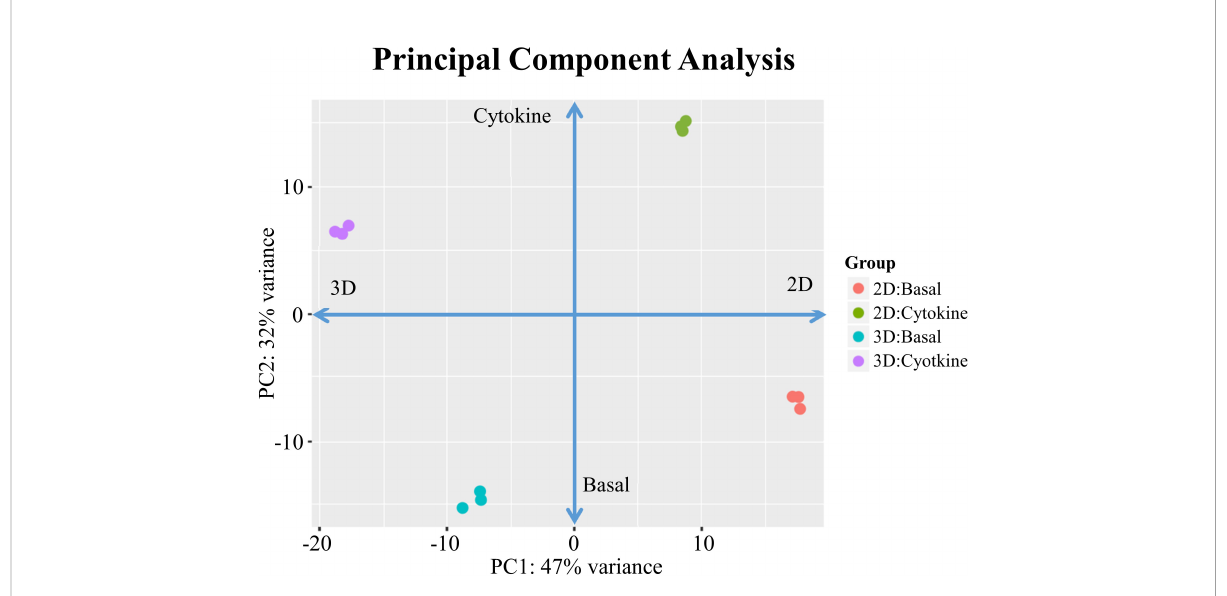
FIGURE 1 PCA for 2D con fl uent and d3/d14 3DSF ECs. PCA shows that treatment with cytokines signi fi cantly shifts gene expression in both 2D and 3D ECs, although each maintain their unique substratum-associated